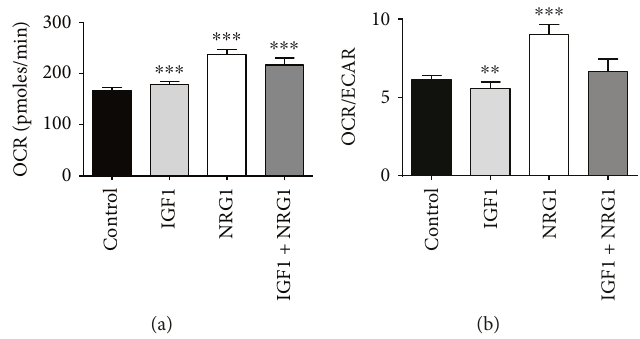
Figure 6: NRG1 treatment increases mitochondrial activity in cardiomyocytes. Basal metabolic pro fi ling of hESC-cardiomyocytes was normalized to live cells (with LIVE/DEAD® staining) to determine oxygen consumption rate (OCR) (a), extracellular acidi fi cation rate (ECAR), and the OCR/ECAR ratio (b) ( n = 6 ). Data are expressed as mean ± SD. ∗∗ P < 0 01 and ∗∗∗ P < 0 001 versus